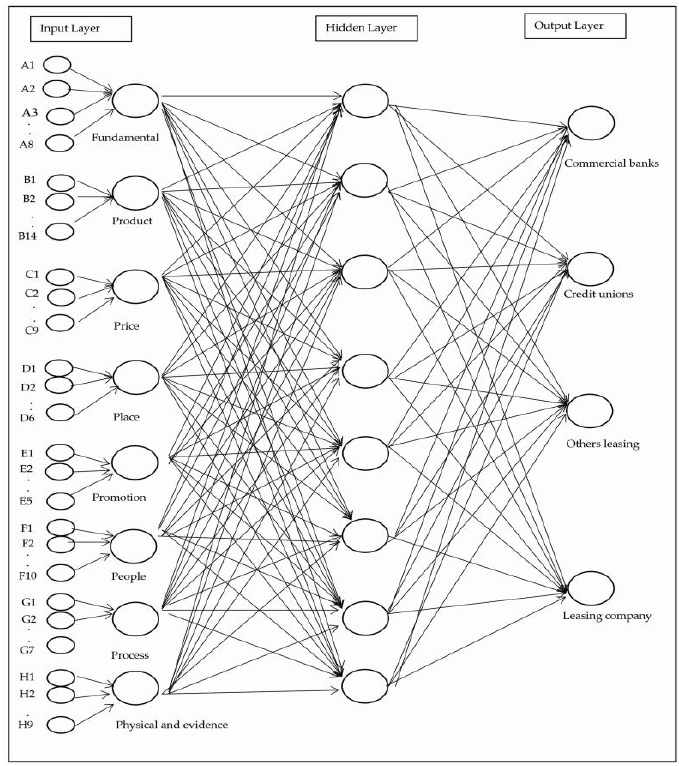
Figure A2. Structure of the NN model used for predicting.